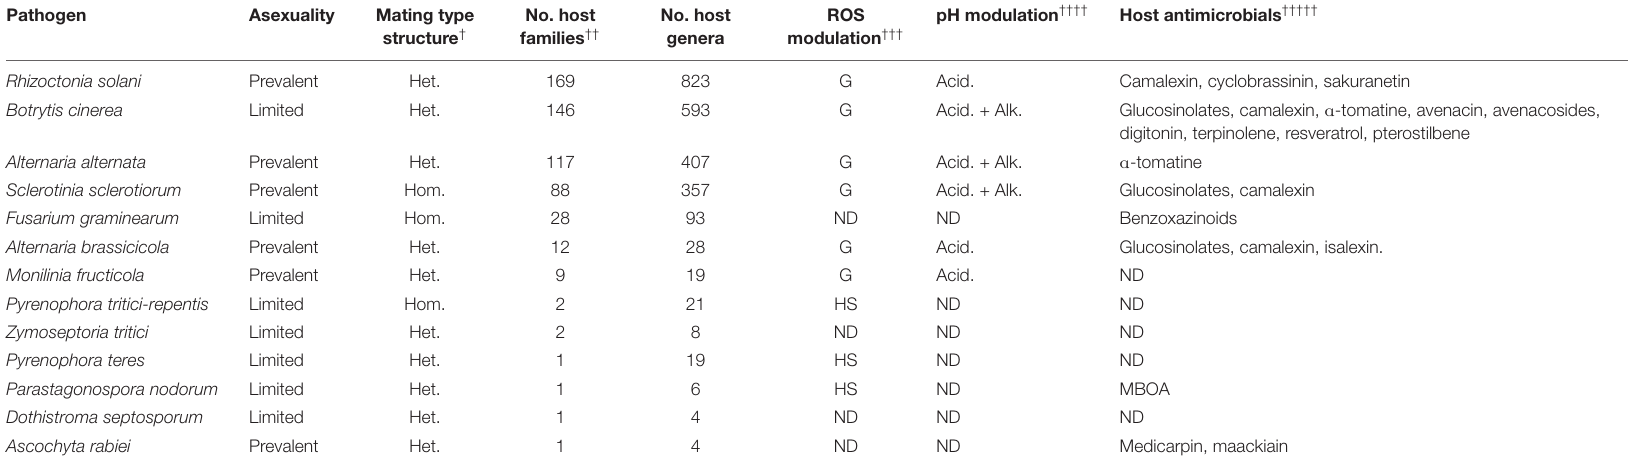
TABLE 1 | A selection of 14 pathogen species and their host ranges with a summary of the various evolutionary and molecular features discussed in this article. Pathogen Asexuality